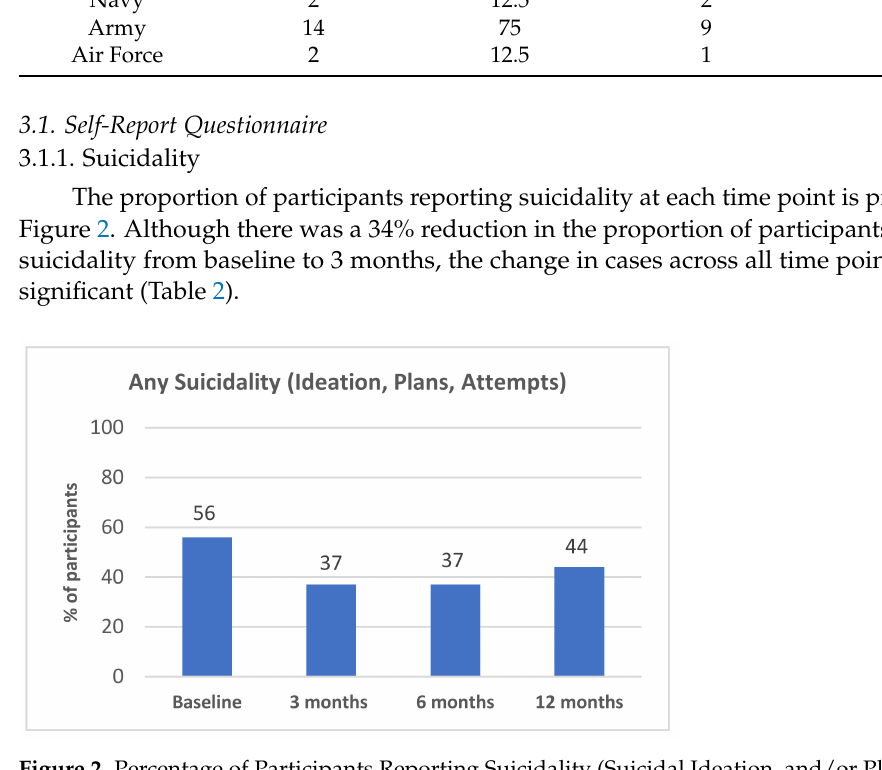
Figure 2. Percentage of Participants Reporting Suicidality (Suicidal Ideation, and/or Plans, and/or Attempts) at Baseline, 3, 6, and 12